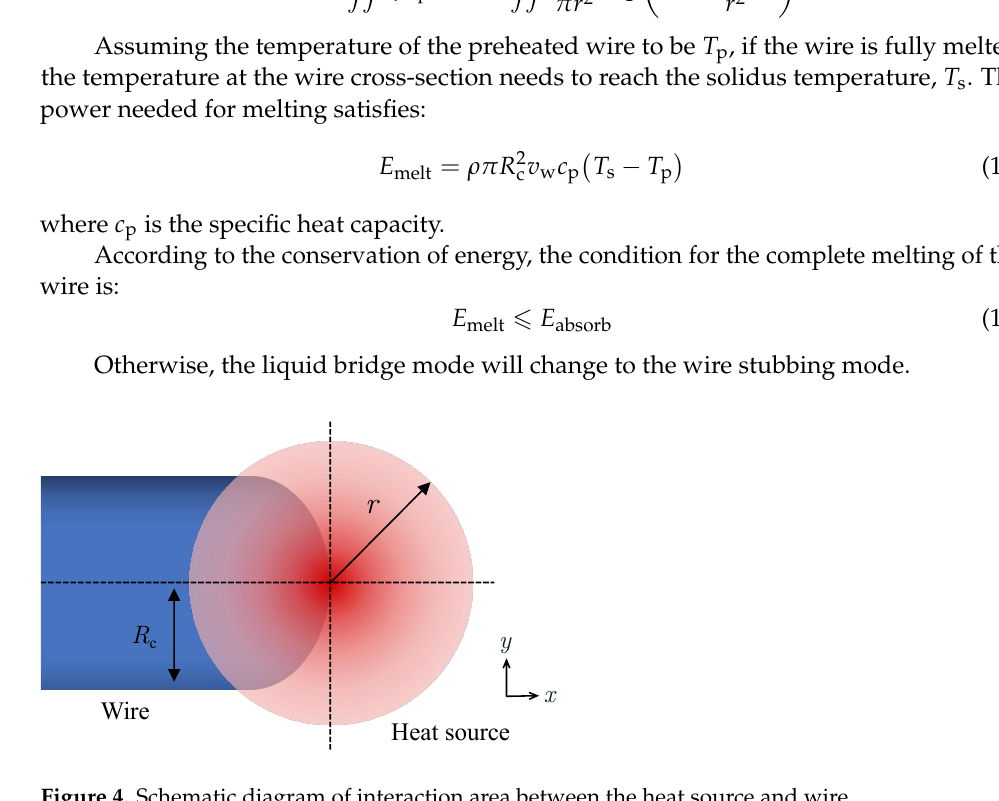
Figure 4. Schematic diagram of interaction area between the heat source and